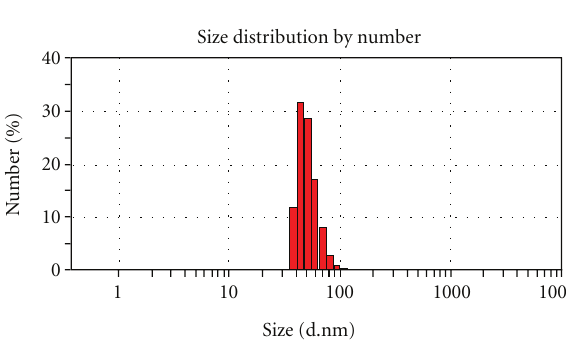
Figure 3: Particle size distribution of Cu 2 O-TiO 2 .